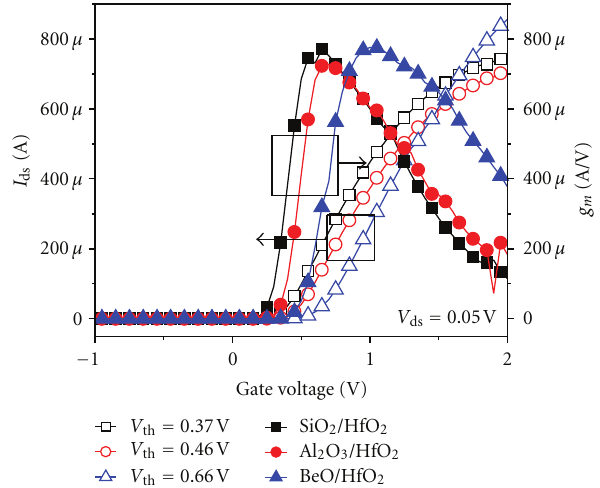
Figure 8: NMOSFETs I d − V g characteristics of three gate stacks. BeO IL shows slightly higher V th , G m , and I d